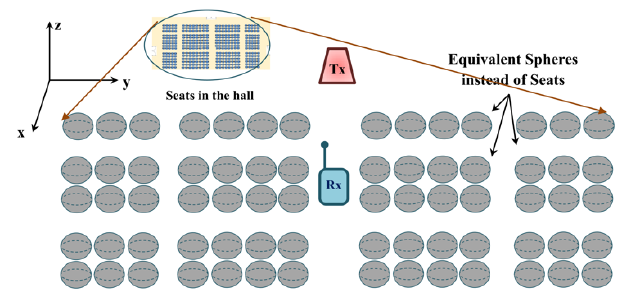
Figure 9. Equivalent spheres instead of stochastic parts (seats) of the channel.